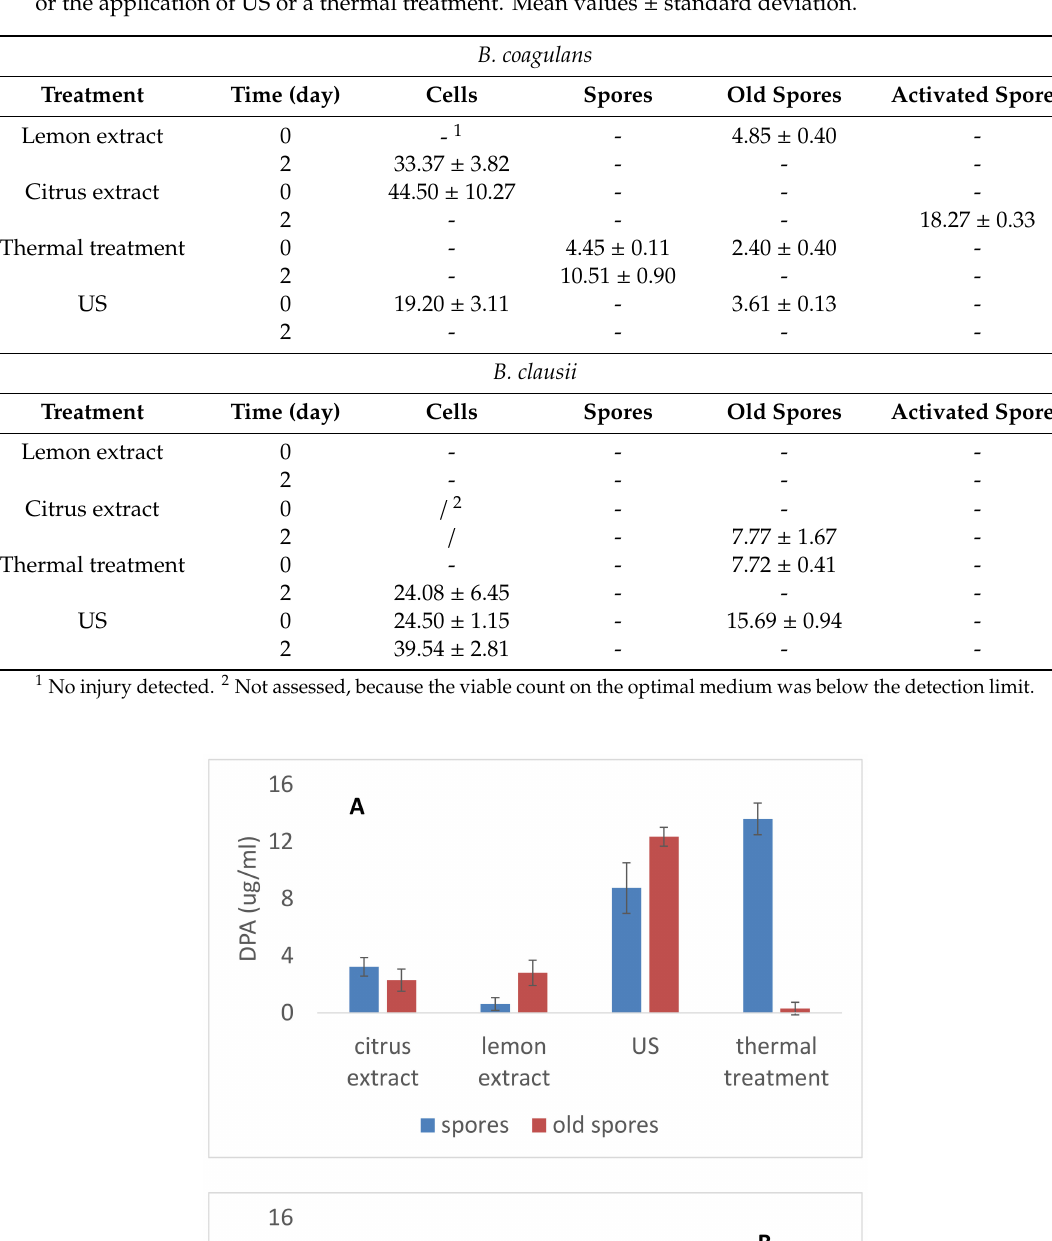
Table 3. Sub-lethal injury (%) on B. coagulans and B. clausii after the addition of citrus or lemon extract or the application of US or a thermal treatment. Mean values ± standard deviation.